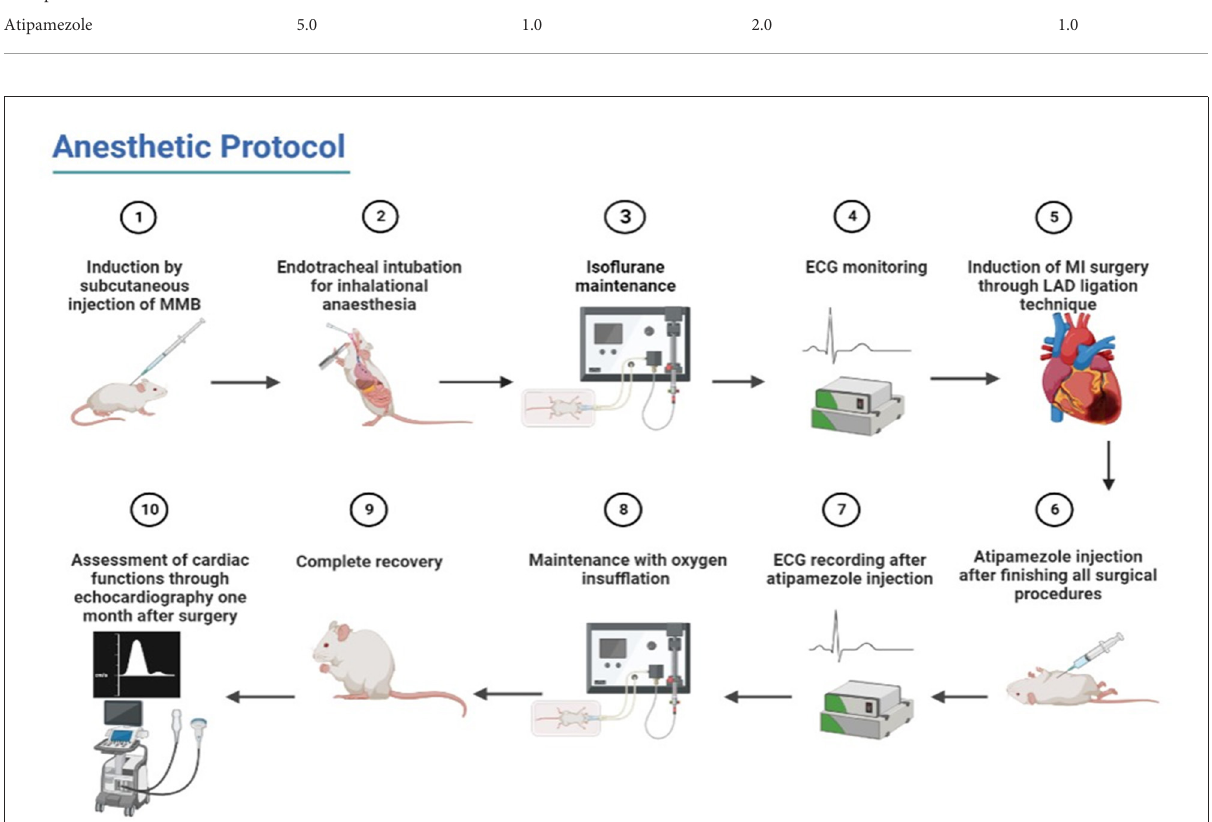
FIGURE1 Schematic illustration of the used procedures of anesthetic protocol from induction to recovery and post-MI confirmation.